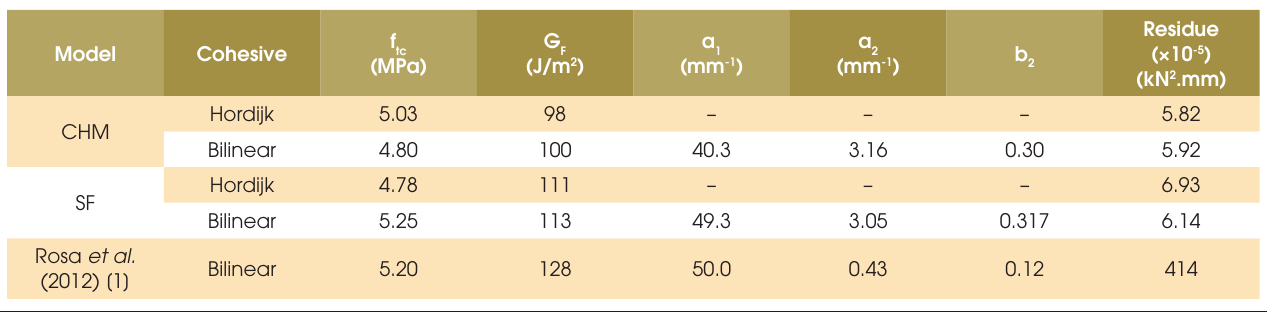
Table 3 – Results of cohesive curves obtained by inverse analysis of the quasi-static envelopes